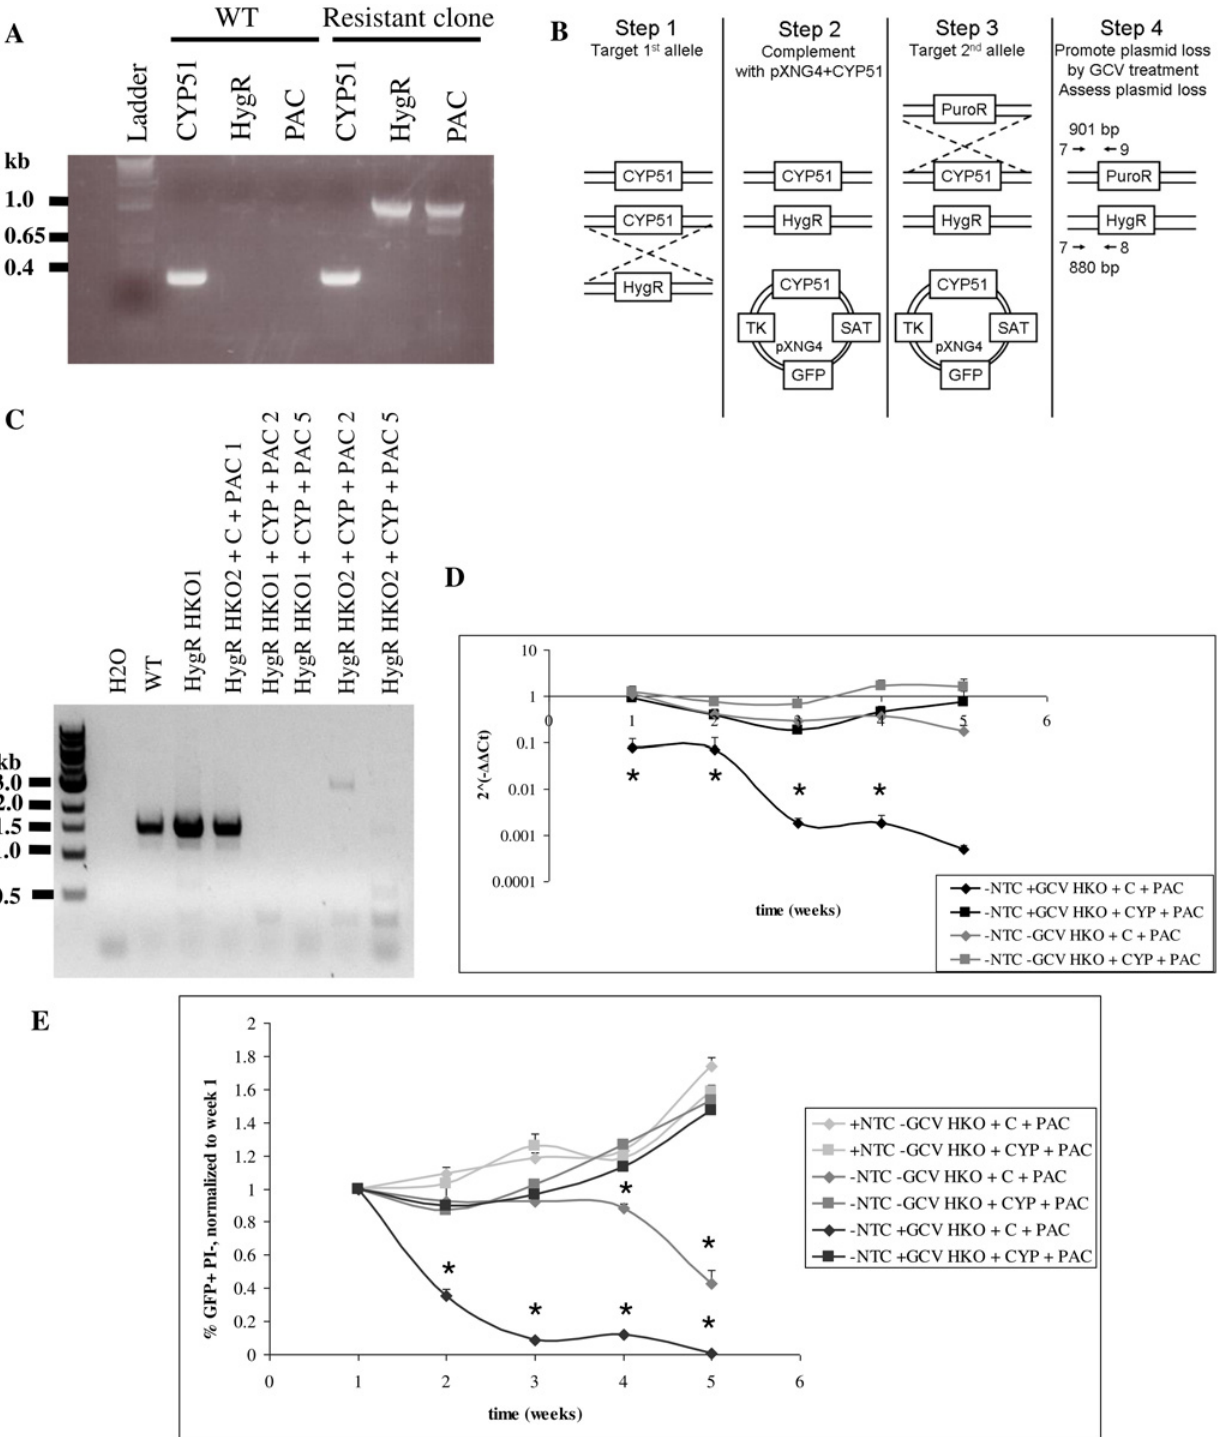
Fig 2. Essentiality of CYP51 in L . donovani . A , Persistence of CYP51 gene even after correct targeting of two knockout cassettes into the CYP51 locus. Correct targeting of the knockout cassettes was verified by PCR using one primer within the knockout cassette and one upstream of CYP51 (primers 7 and 8 (hygromycin) or 7 and 9 (puromycin)). CYP51 was amplified with primers within the coding region (primers 10 and 11). B , Targeting strategy. Primers 7 and 8 or 7 and 9 and expected PCR product sizes to confirm correct targeting of chromosomal CYP51 alleles are indicated by arrows (step 4). C , Loss of chromosomal CYP51 in the presence of episomal CYP51 complementation but not in strains complemented with the empty vector. PCR was performed